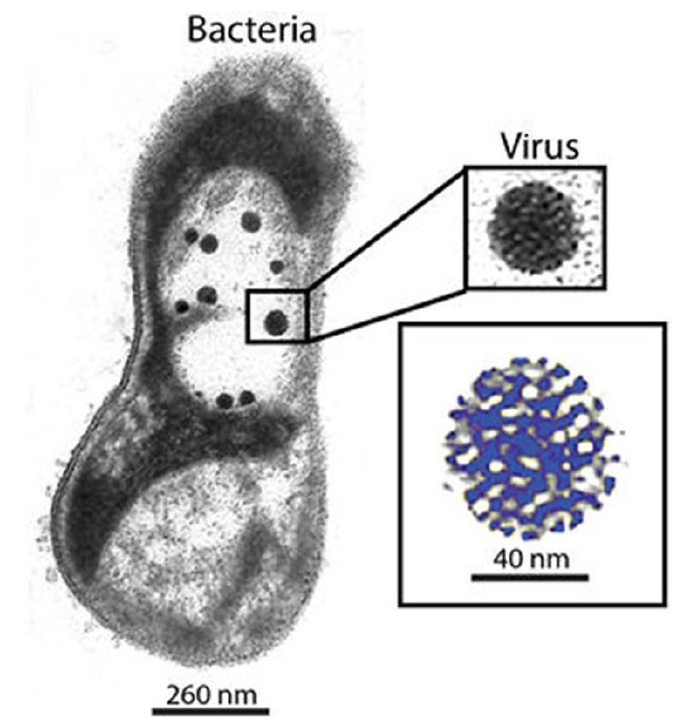
Figure 3. Image of an aquatic ecosystem bacterium infected with viruses, observed by transmission electron microscopy. The black “dots” indicate the presence of non-tailed bacteriophages in the bacterial cytoplasm. The boxed area shows a zoomed-in view of the structure of the viral protein capsule (capsid), composed of several repetitive morphological units (highlighted in blue). Image reproduced from Barros et al. (2010), with